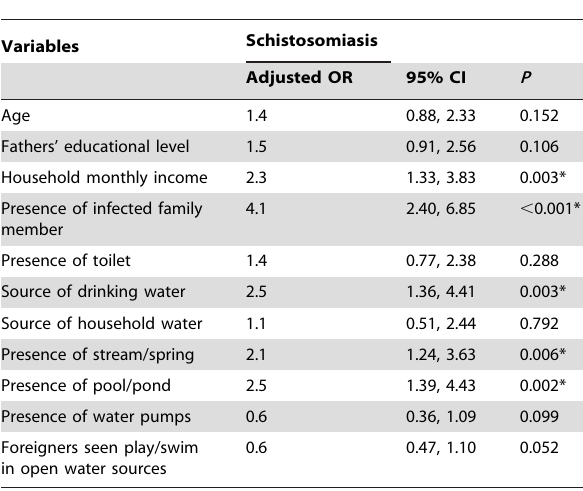
Table 4. Multivariate analysis of factors associated with schistosomiasis among Yemeni children participated in this study (n=